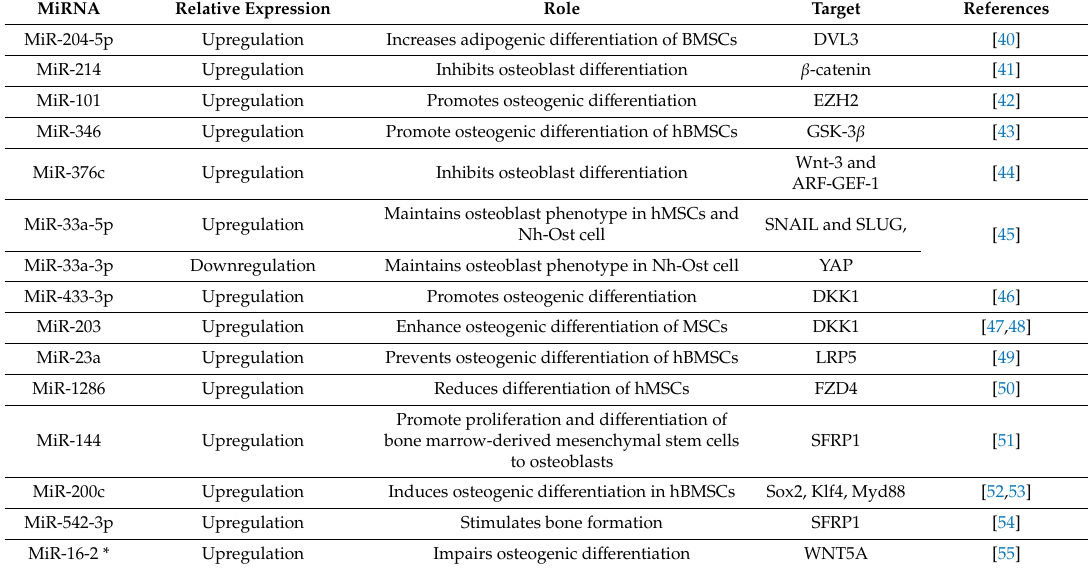
Table 2. BMSCs regulation through the Wnt signaling